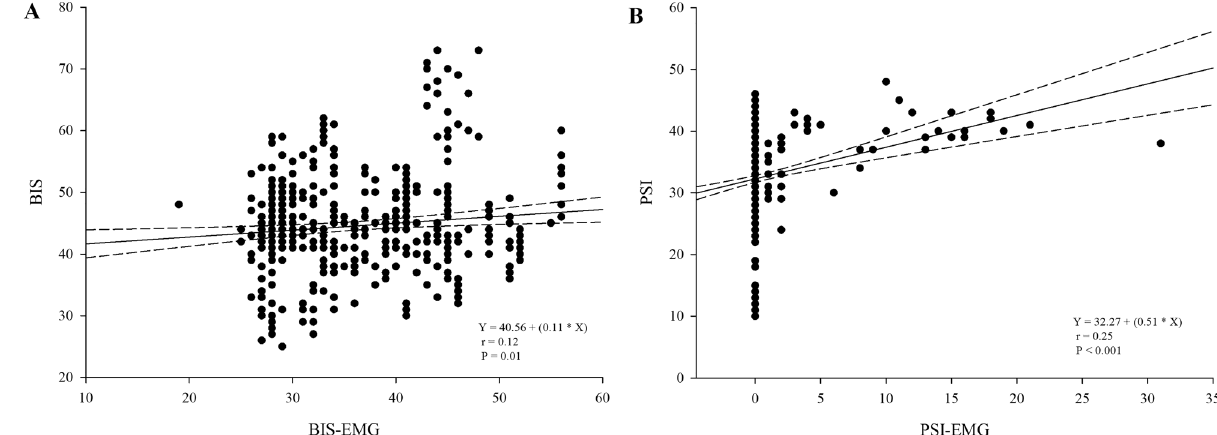
Figure 4. Correlations between each parameter and their electromyography (EMG) values during 10 min after sugammadex administration. ( A ) correlation between bispectral index (BIS) and BIS-EMG values, ( B ) correlation between patient state index (PSI) and PSI-EMG values. BIS-EMG EMG recorded by the BIS electrode, PSI-EMG EMG recorded by the PSI